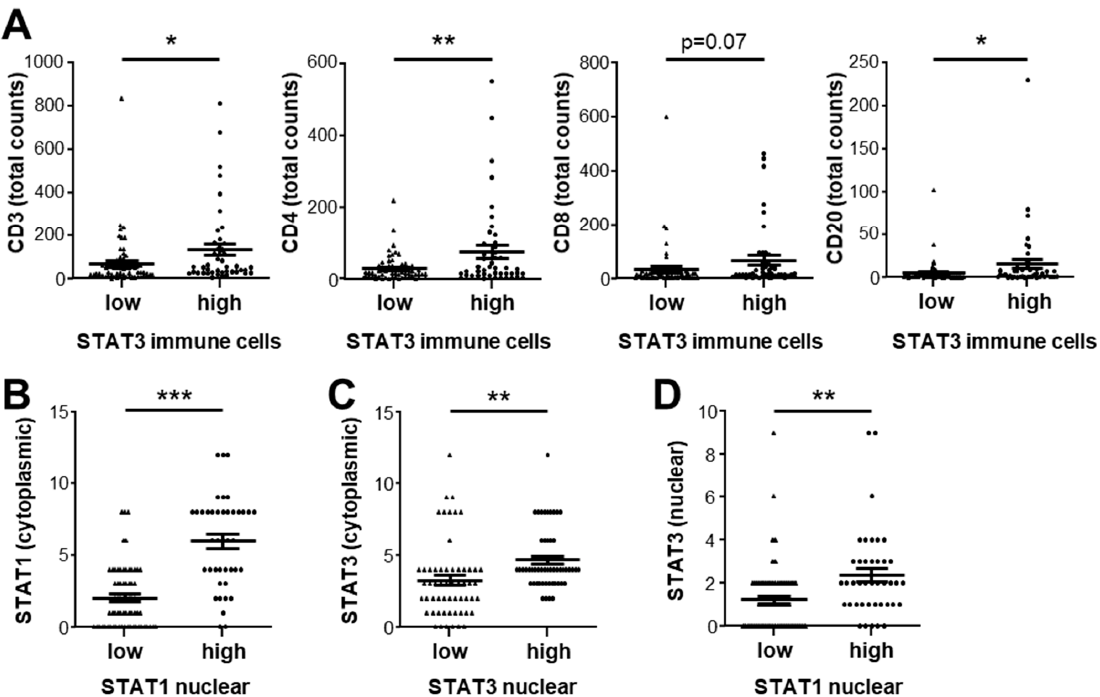
Figure 6. Association between STAT1 and STAT3 expression in the tumor epithelium and immune cell compartment in HCC tumor samples. ( A ) CD3-, CD4-, CD8-, and CD20-positive immune cell infiltrate in HCC tumor tissue samples stratified by median count of STAT3-positive immune cells. ( B ) Cytoplasmic STAT1 expression IRS in HCC tumor samples stratified by median nuclear STAT1 expression. ( C ) Cytoplasmic STAT3 expression IRS stratified by median nuclear STAT3 expression. ( D ) Nuclear STAT3 expression IRS stratified in patient samples grouped by median nuclear STAT1 expression. * p < 0.05; ** p < 0.01; *** p < 0.001.